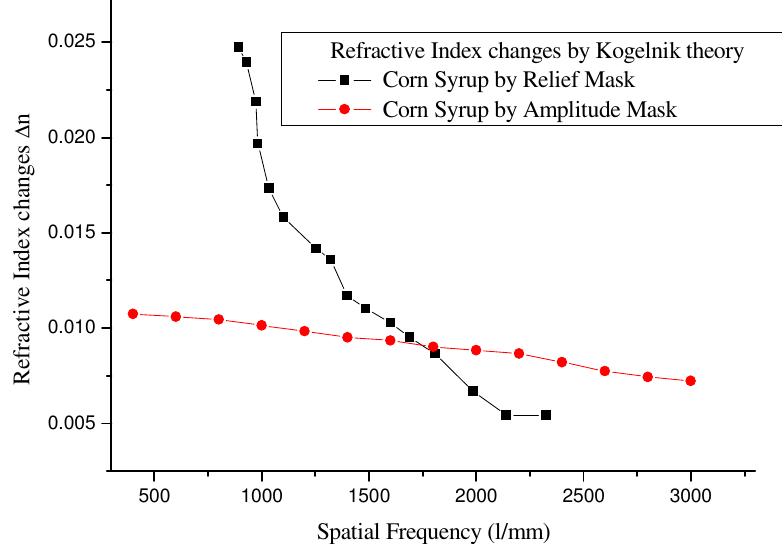
Figure 8. Behavior of spatial frequency vs. refractive index changes